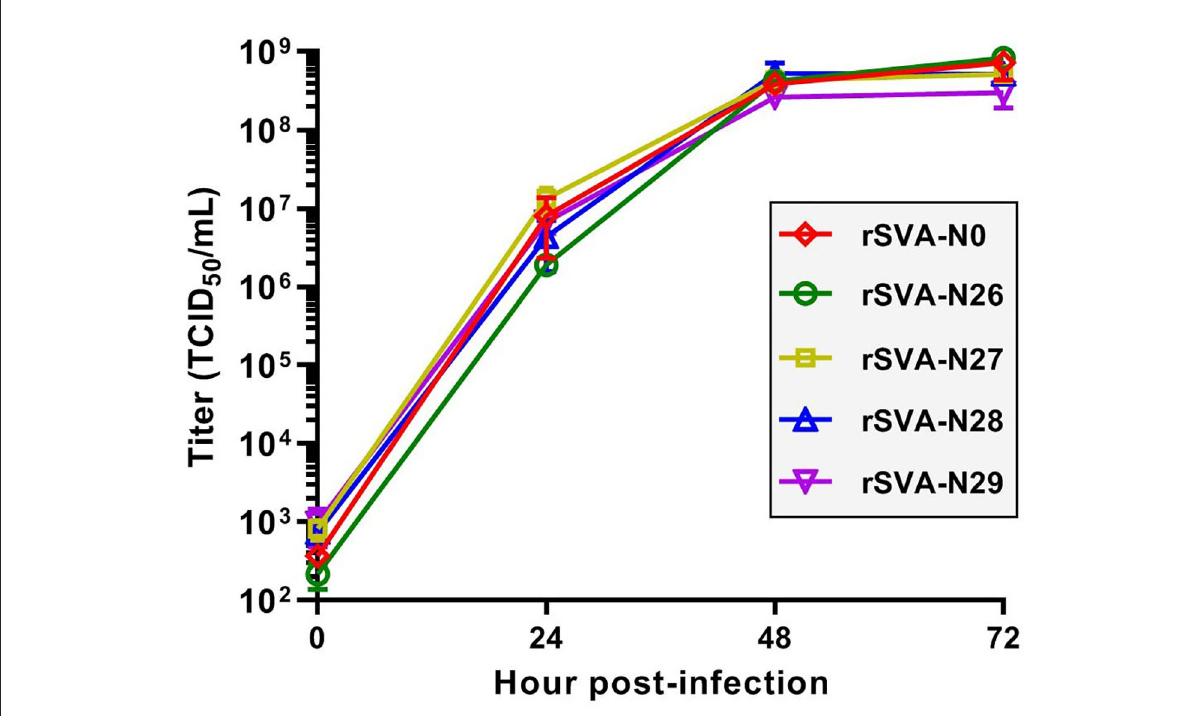
FIGURE7 Multistep growth curves of rSVAs at P4. Data at 0, 24, 48 and 72 hpi are representative of three independent experiments. Error bar indicates standard